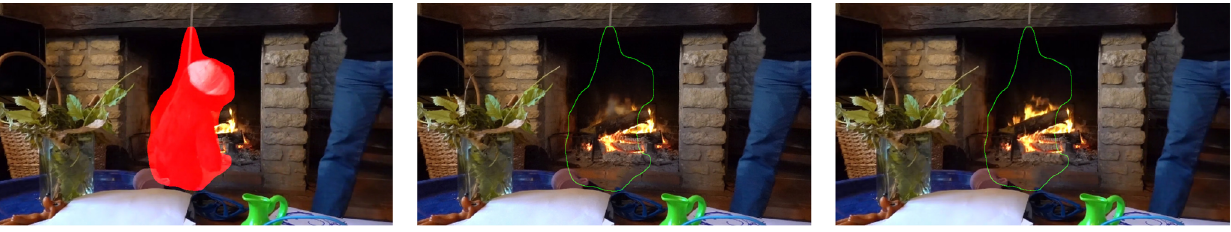
Fig. 11 Qualitative comparison with Huang et al.’s method [61] on video with a dynamic background. Left to right: our segmentation mask, result from Ref. [61], our inpainting result performed on our